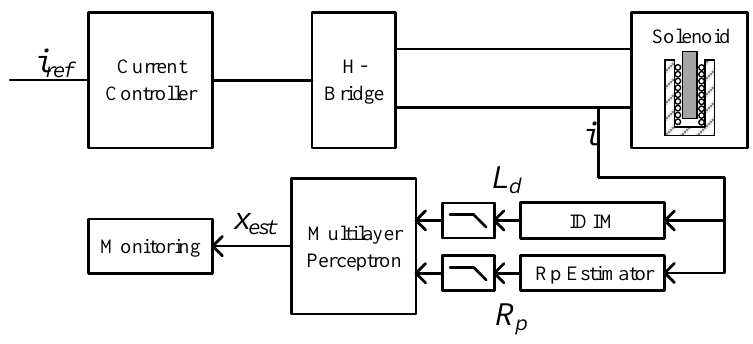
Figure 10. Schematic of the position estimation algorithm together with current controller, H-bridge and solenoid actuator.